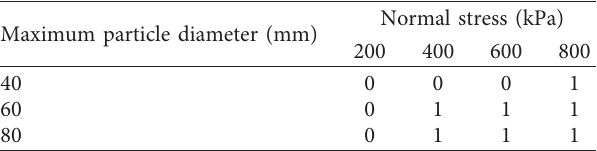
Figure 5: Shear stress vs shear displacement under different maximum particle diameters. (a) 40mm. (b) 60 mm. (c) 80mm. Table 2: Occurrence of secondary hardening under different